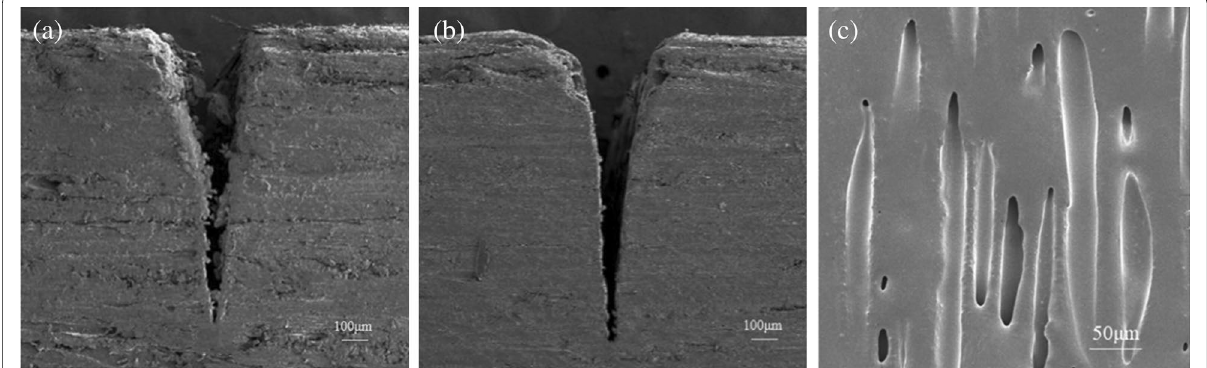
Fig. 13 Gas-assisted laser cut wood surface optimization. a Traditional laser machining. b Gas-assisted laser processing. c Micromorphology of kerf